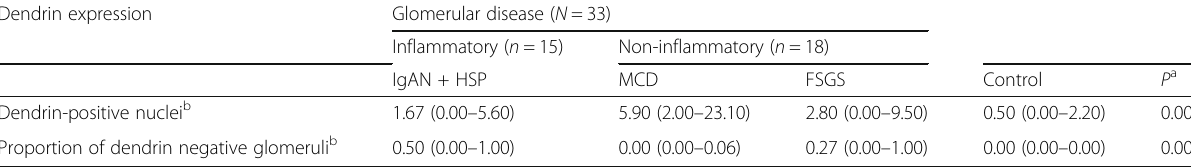
Table 2 Number of dendrin positive nuclei and proportion of dendrin negative glomeruli in glomerular diseases